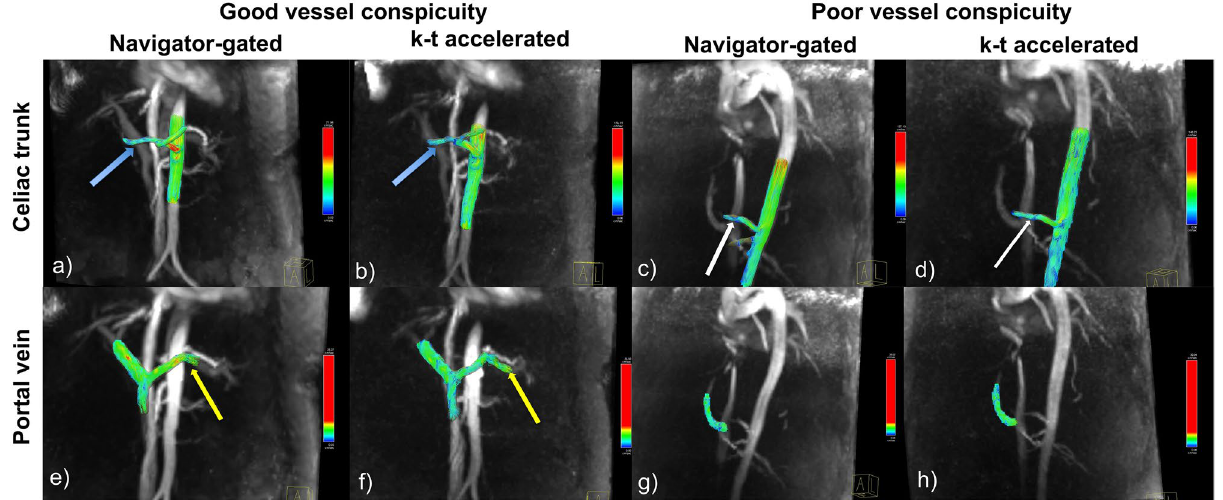
Figure 1. Example of good vessel conspicuity on both the navigator-gated and k−t accelerated sequence, in a 64 year-old female with HVPG = 14 mmHg ( a , b , e , f ), and of poor vessel conspicuity, in a male, 57 year-old patient with HVPG = 17 mmHg ( c , d , g , h ). The hepatic artery (blue arrow; a , b ) had a vessel conspicuity score of 2 on both acquisitions, while the the supraceliac aorta, celiac trunk, splenic artery ( a , b ), portal vein, SMV ( e , f ) all had a vessel conspicuity score of 3 on both acquisitions. The SV (yellow arrow) had a score of 3 on the navigator-gated sequence ( e ), and a score of 2 on the k−t accelerated sequence ( f ). In the case with poor vessel conspicuity, the hepatic artery (white arrow; c – d ) had a score of 1 on both acquisitions, the supraceliac aorta, celiac trunk, hepatic artery ( c , d ) and portal vein ( g , h ) had a score of 3 on both acquisitions, while the splenic artery, SMV, and SV ( g , h ) were scored 0 (not seen) on both acquisitions. Background noise and artifacts were scored as 3 (minimal to none) for both cases with both